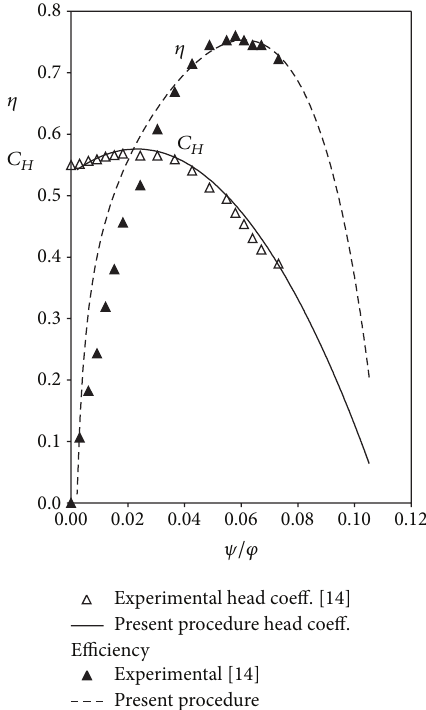
Figure 9: Comparison between present procedure results and experimental results by Baun and Flack